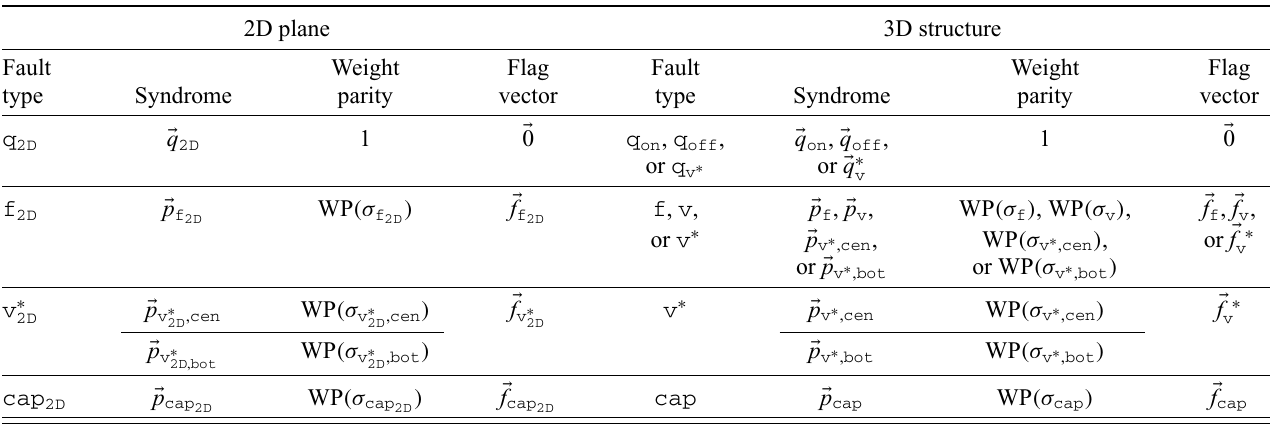
TABLE III. The correspondence between the notation for types of faults on the 2D plane and the 3D structure. 2D plane 3D